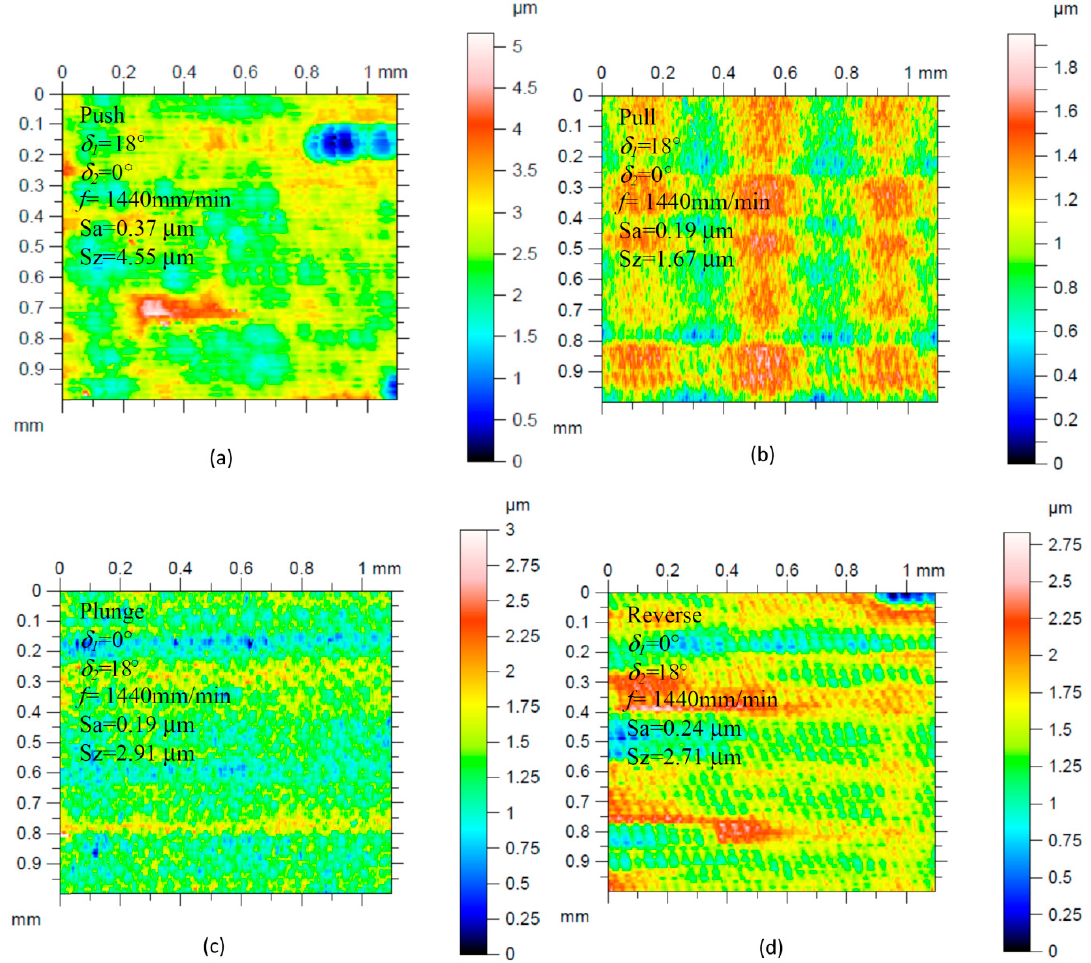
Figure 5. Isometric views of the exemplary surface roughness made with different tool tilt strategies: (a) Pusch; (b) Pull; (c) Plunge; (d) Reverse, constant parameters n = 27000 rev/min and a e = 0.025 mm.